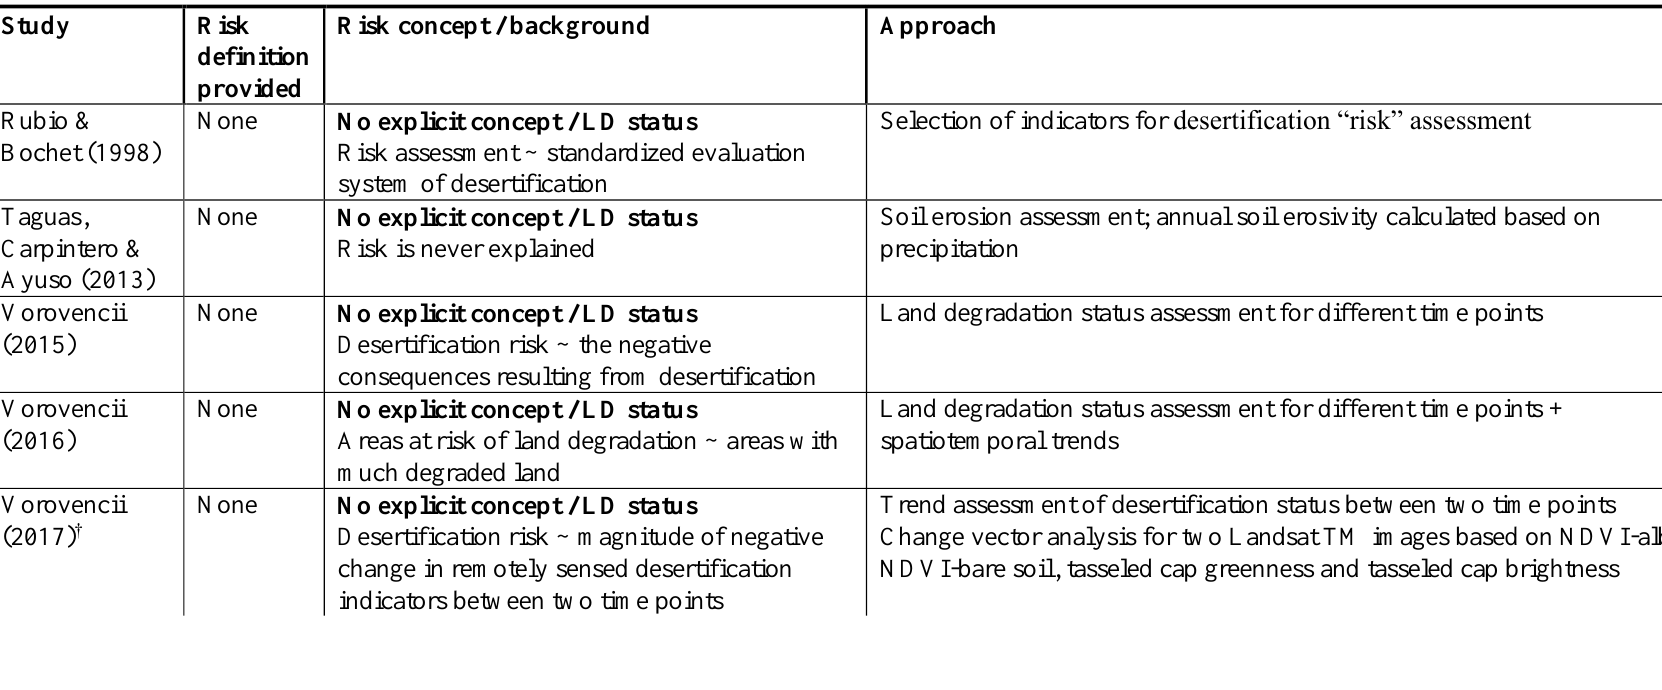
Table A1. Overview of the studies that were included in the literature analysis on land degradation risk assessment approaches, including their risk concept and a summary of the overall approach. The original search in the Web of Science was performed for a PhD thesis in 2017 (von Keyserlingk 2021). For this article, a new search was conducted covering the time period from 1900 to 2021-12-22. All studies that were added during the second search are marked by footnotes. LD is used as an abbreviation for “land